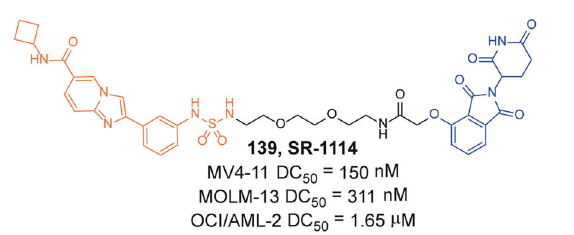
Fig. 32 The representative PROTAC targeting